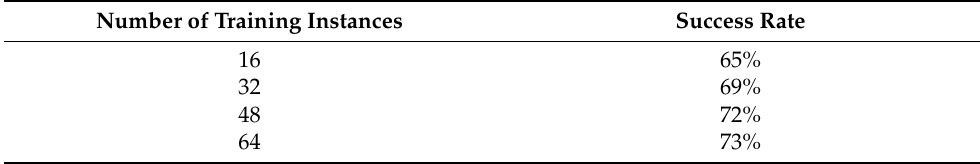
Table 13. Robustness